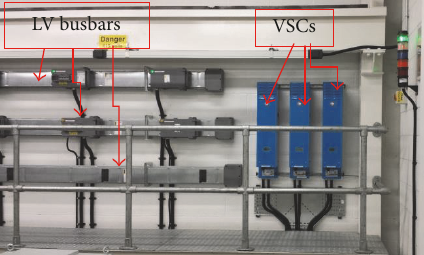
Figure 9: Laboratory setup showing 415LV busbars and 3 VSCs.